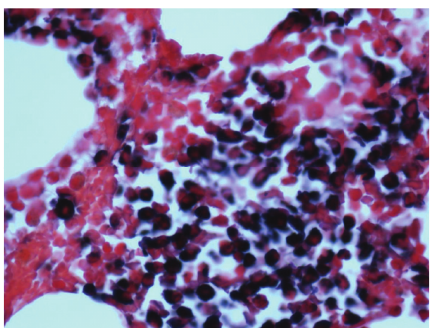
Figure 2: Immunohistochemistry of the bone marrow biopsy showing positivity for lambda light chains.